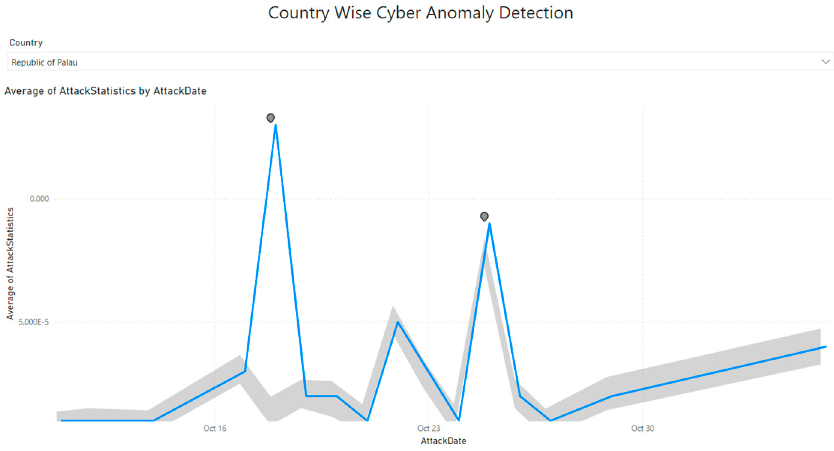
Figure 5. CNN-based deep learning Algorithm used for identifying anomalies in cyber-attacks for the Republic of Palau.